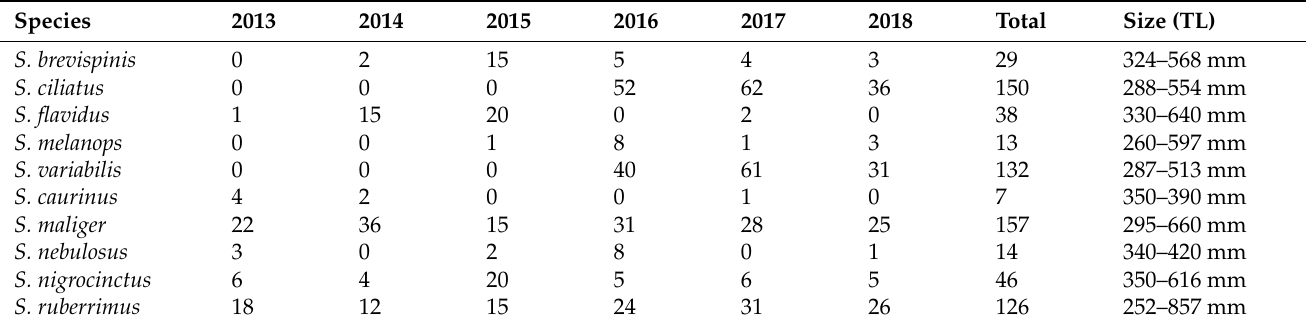
Table 1. Sample sizes by year and size range for each species of the rockfish